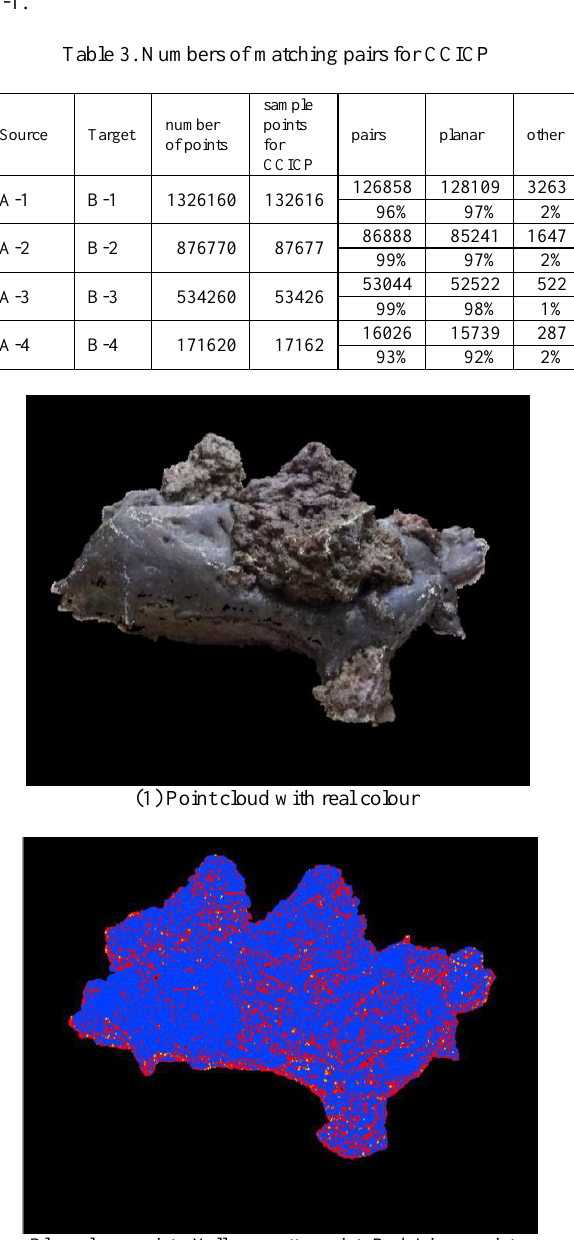
Figure 11. PCA classification of A-1